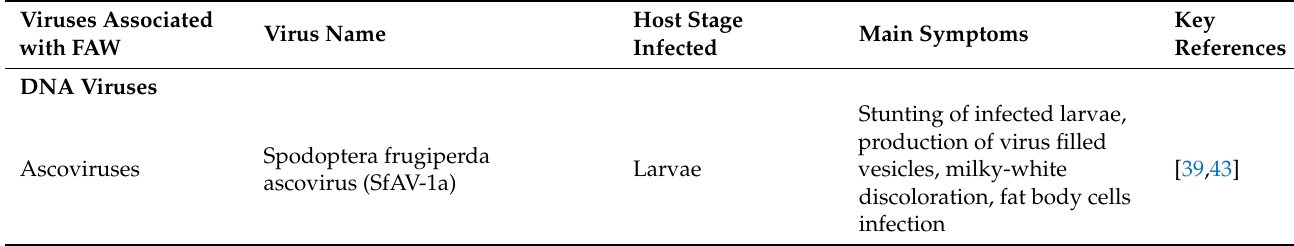
Table 1. Virus families associated with FAW, host stage infected, symptoms, and key references. Viruses Associated with FAW DNA Viruses